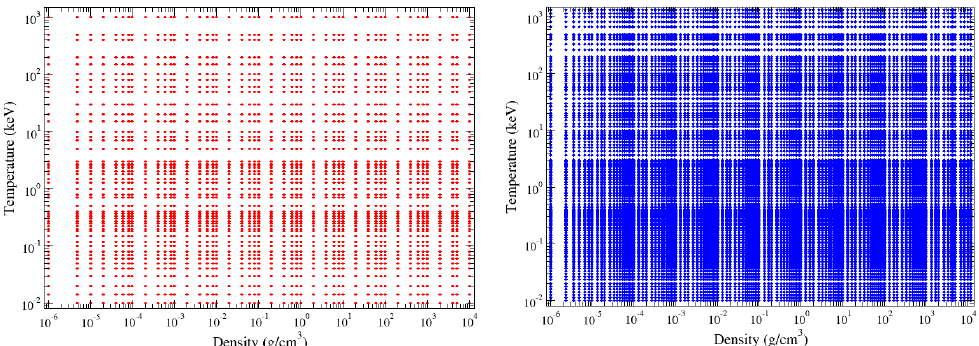
Figure 17. First grid containing 47 densities and 50 temperatures, i.e., 2350 points. Second grid containing 140 densities and 150 temperatures, i.e., 21,000 points.